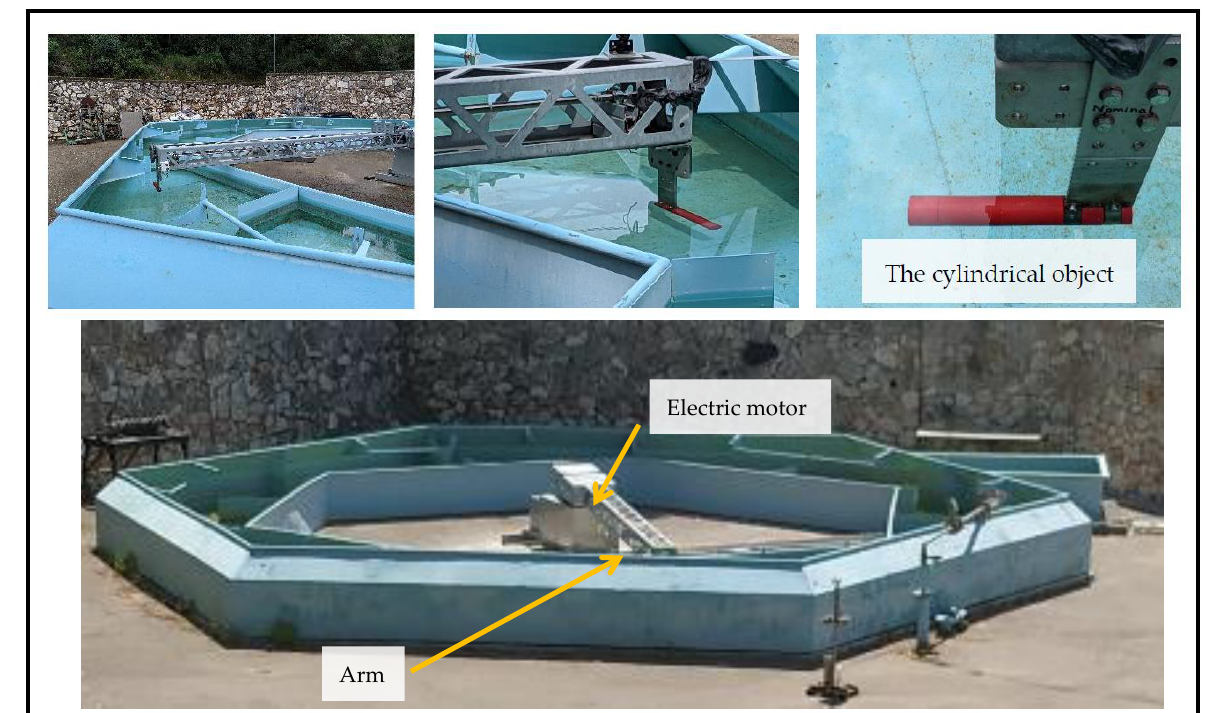
Figure 2. The experimental system.